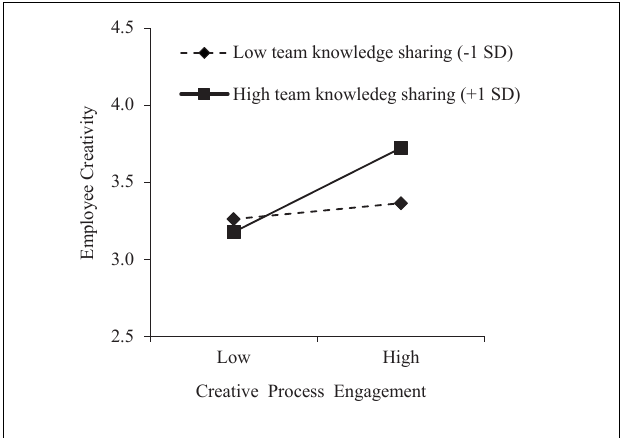
FIGURE 2 | Team knowledge sharing moderates the effect of creative process engagement on employee